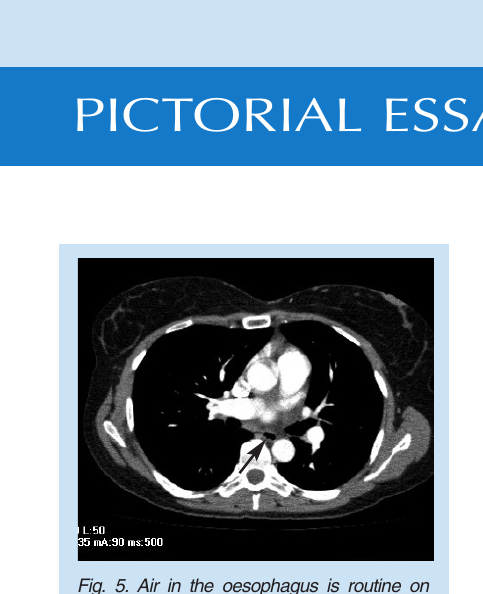
Fig. 5. Air in the oesophagus is routine on multi-detector CT.